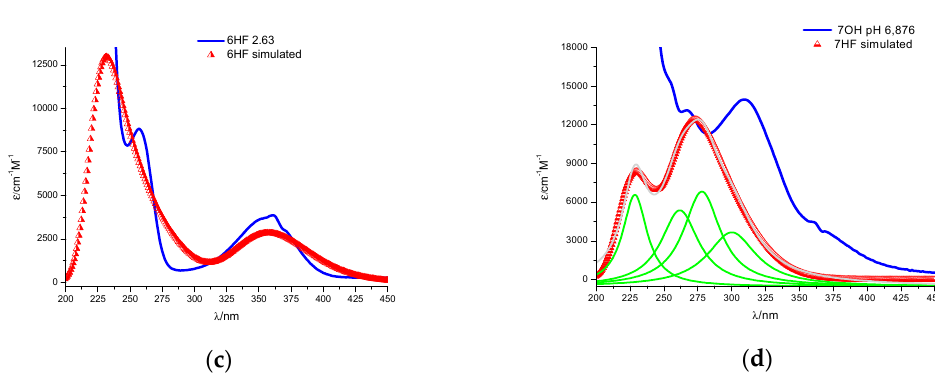
Figure 7. Experimental and simulated UV–Vis spectra of the flavanones: ( a ) F, ( b ) 2’HF, ( c ) 6HF and ( d ) 7HF. (Origin(Pro) software using the original files from the instrument: Perkin-Elmer Lambda 11 spectrophotometer).